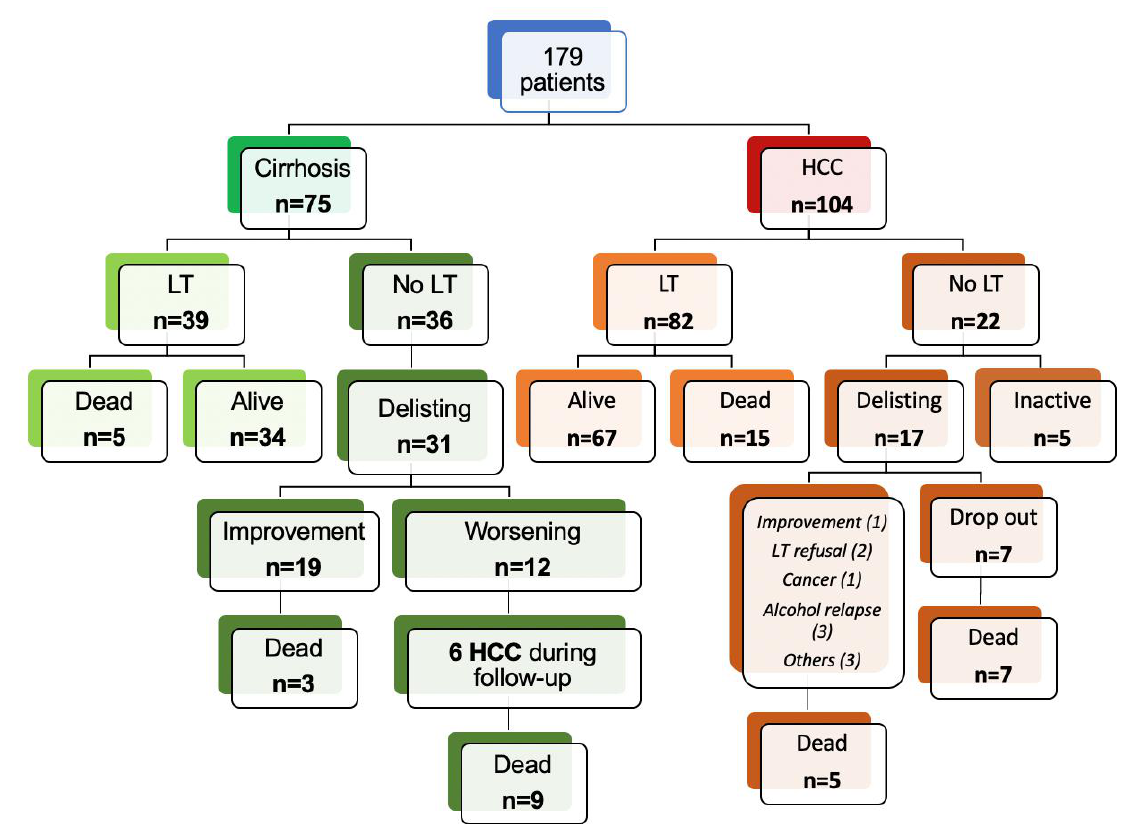
Figure 1. Description of the cohort. HCC: hepatocellular carcinoma; LT: liver